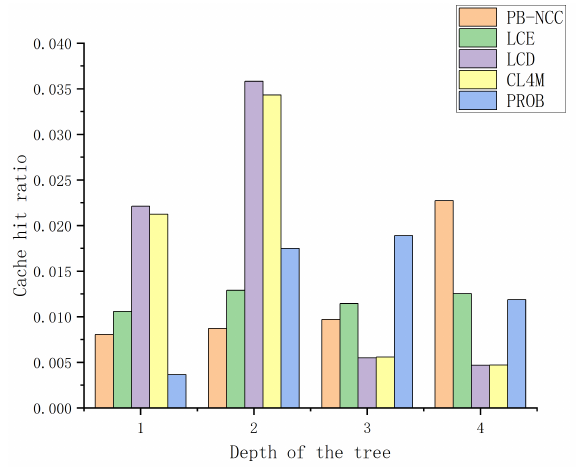
Figure 5. Performance of different cache strategies in different node depths.